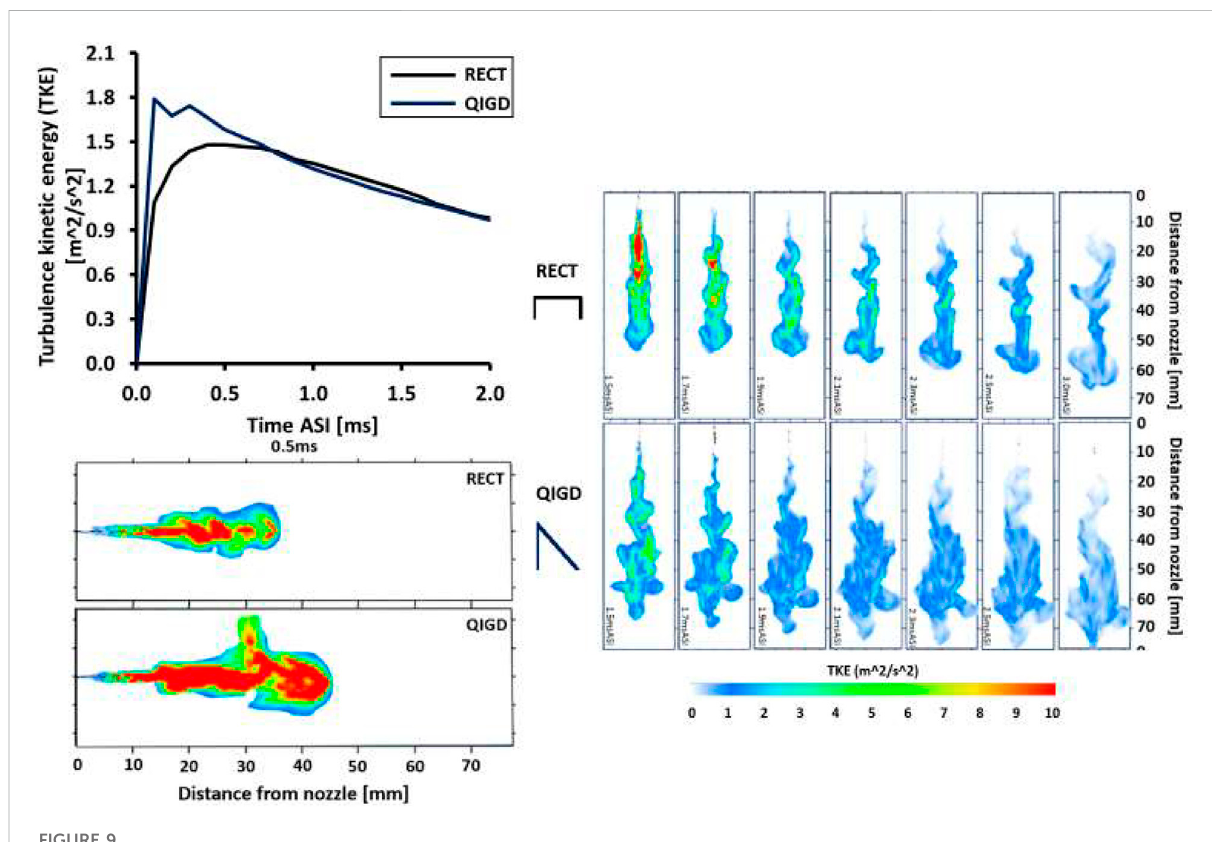
FIGURE 9 TKE values and TKE distribution for RECT and